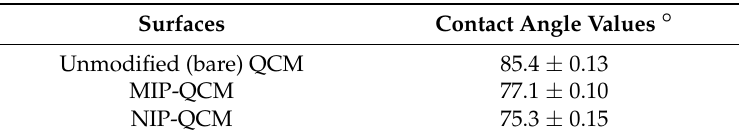
Table 1. The contact angle values.